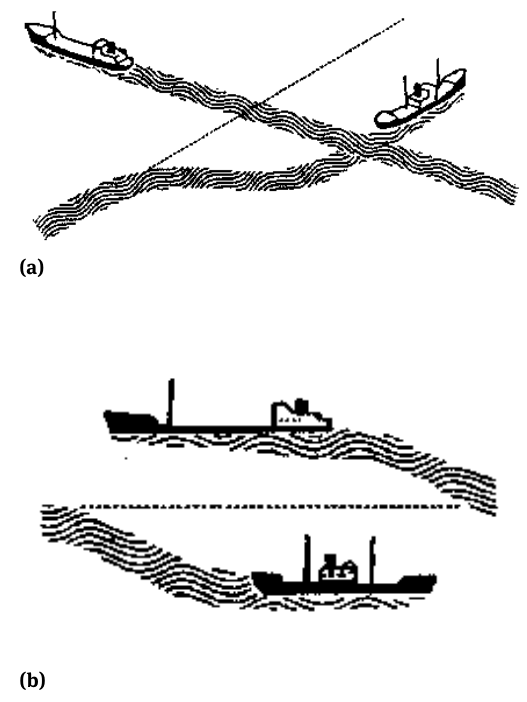
Figure 1: Close-quarters situations for ship manoeuvring: (a) cross- ing situation, and (b) head-on situation